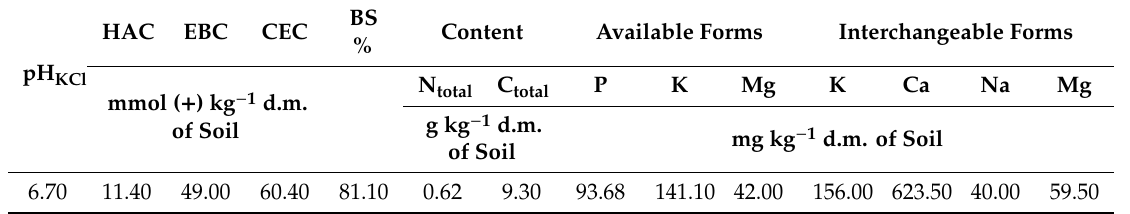
Table 1. Physicochemical and chemical soil properties.